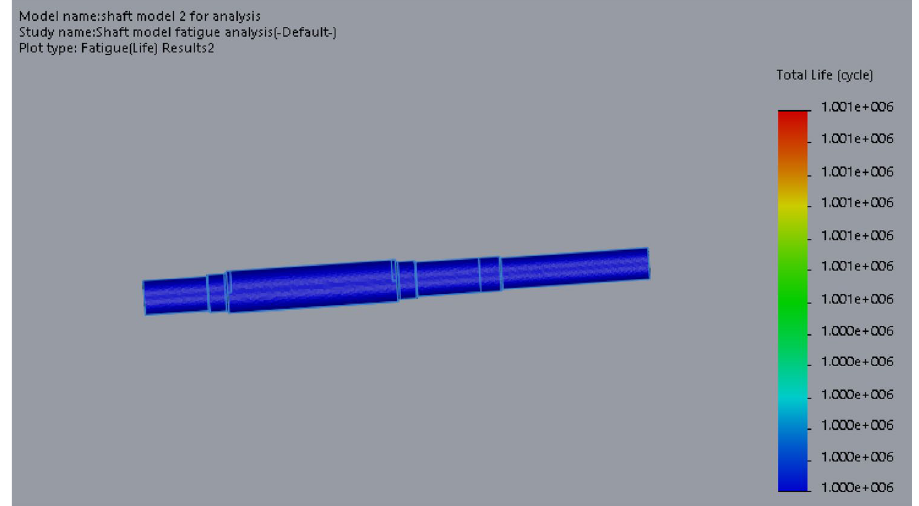
Figure 26. Fatigue life plot.